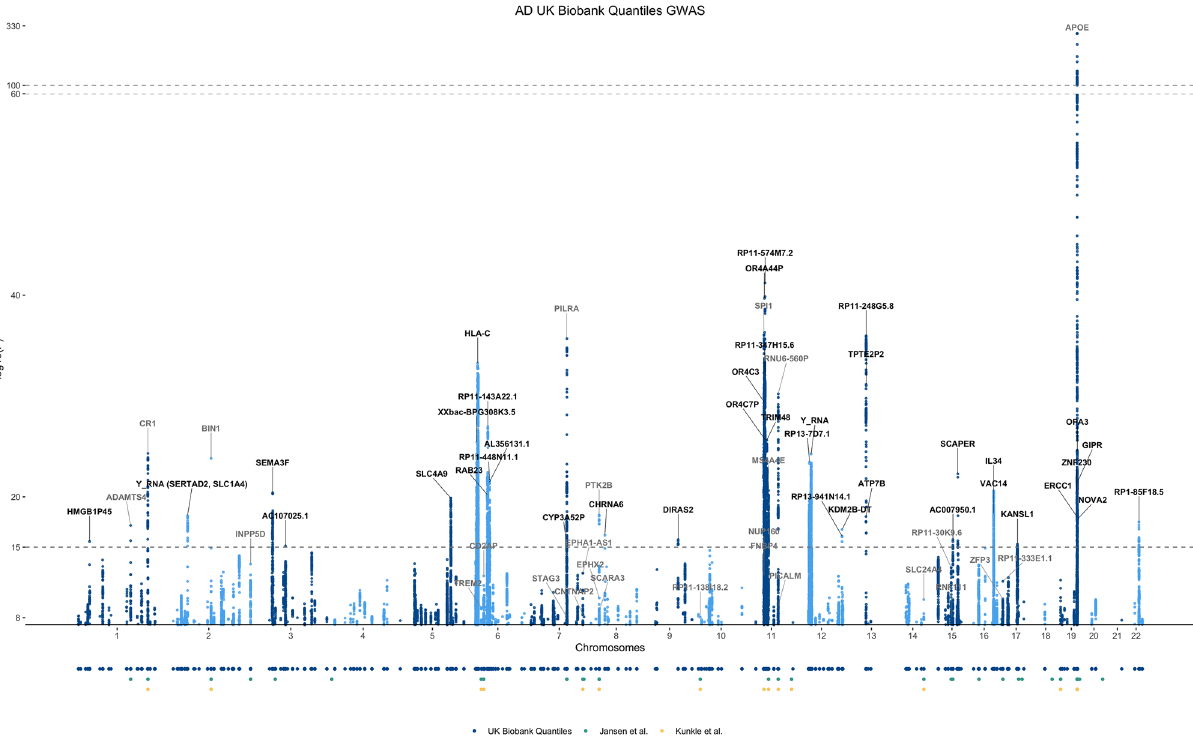
Figure 2. Manhattan plot of the GWAS performed in AD PRS extremes. We compared results with those from Refs. 7,8 . Genomic loci are labeled with the gene name that is nearest to that position. Black labels indicate novel signals; grey labels show previously replicated loci. The bottom panel shows the location of the significant variants depicted in the Manhattan plot that reached significance in the studies considered. Signals were annotated with FUMA 15 and LocusZoom 16